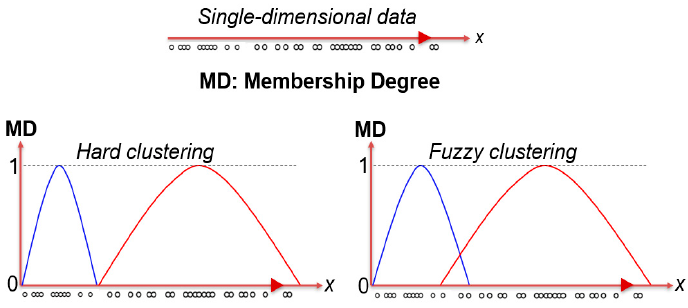
Figure 7. Conceptual dendrogram for fuzzy ‐ logic (FL) [35].